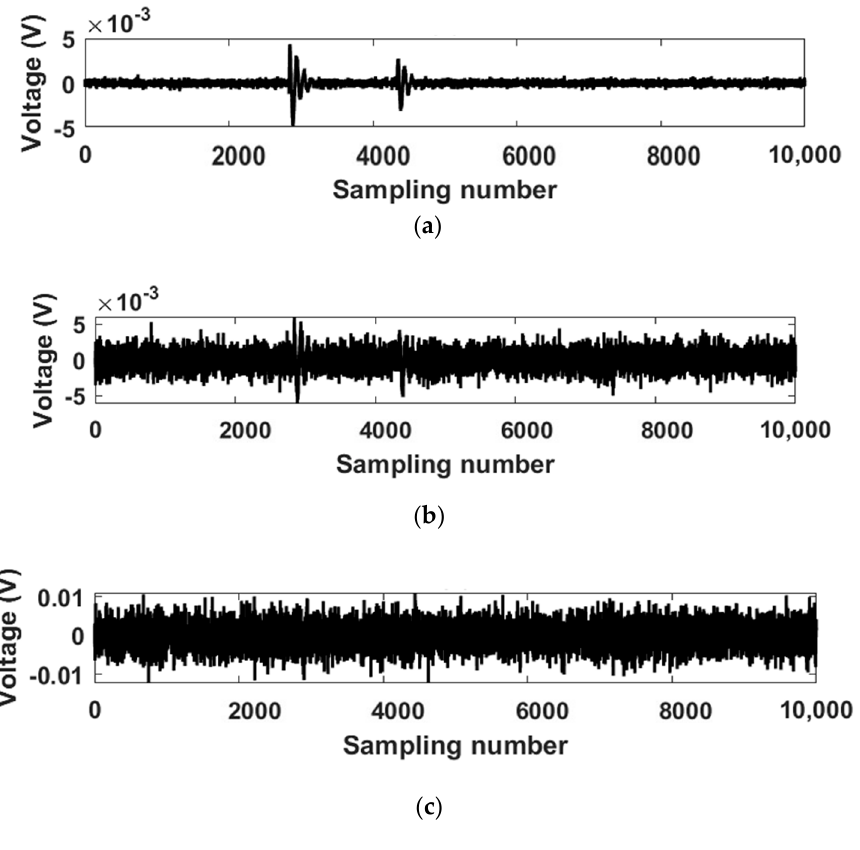
Figure 8. ( a ) PD signals added with 4 dB SNR. ( b ) PD signals added with − 10 dB SNR. ( c ) PD signals added with − 18 dB SNR.